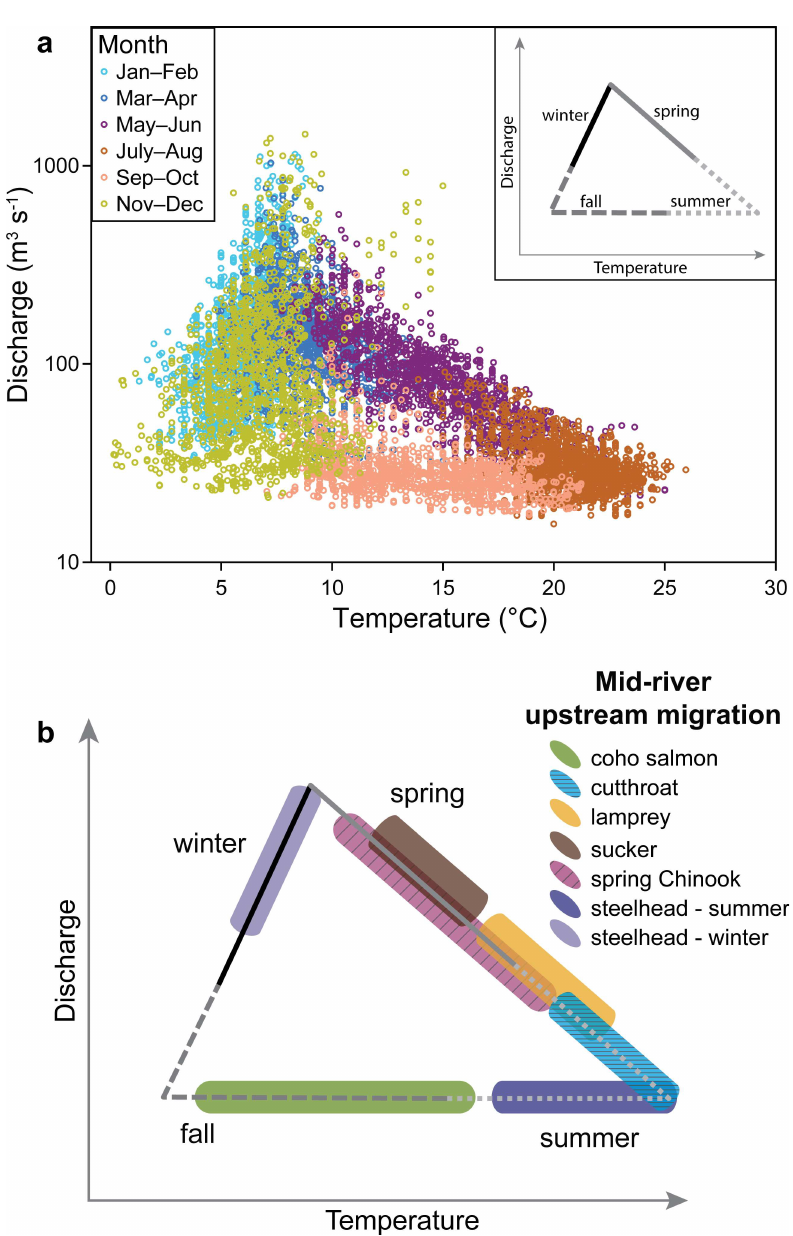
Fig 3. Streamflow and streamtemperature related to fish passage timing at Winchester Dam, OR. Multipleyears of streamflow and stream temperature, when plotted against one another on a graph, may show a cyclicalpattern. Such is the case at Winchester Dam, OR when streamflowand stream temperature for the periodof record (1992–2103) is plotted as: (a) averagedaily values; inset) generalized seasonal relationship creating an annualcycle of hydrologic conditions. When fish passageis overlaidon the frameworkof dischargeand temperature, an ichthyograph is created: (b) ichthyograph of daily fish use at Winchester Dam basedon data from Fig 1. Various other phenological traits could be plotted in this way, with ideal data basedon empiricalobservation,as is the case at Winchester Dam, OR.